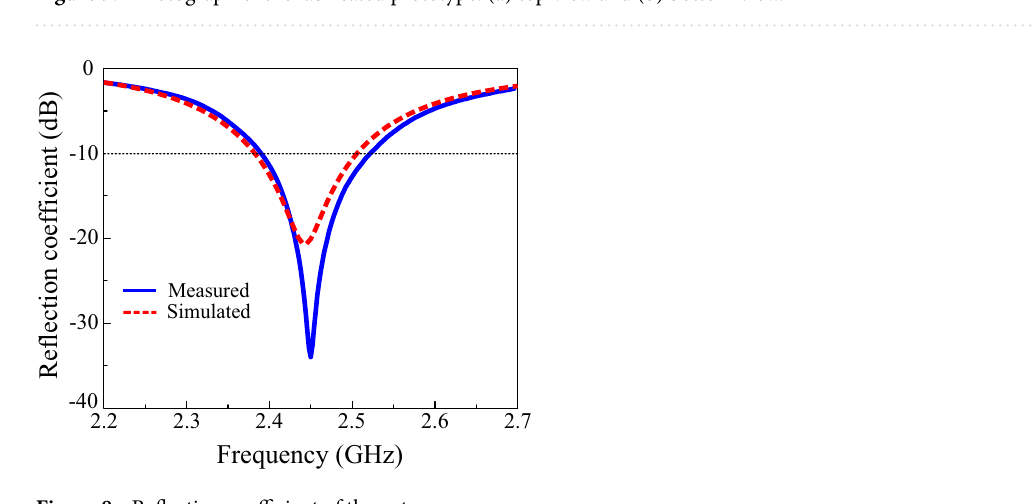
Figure 8. Reflection coefficient of the